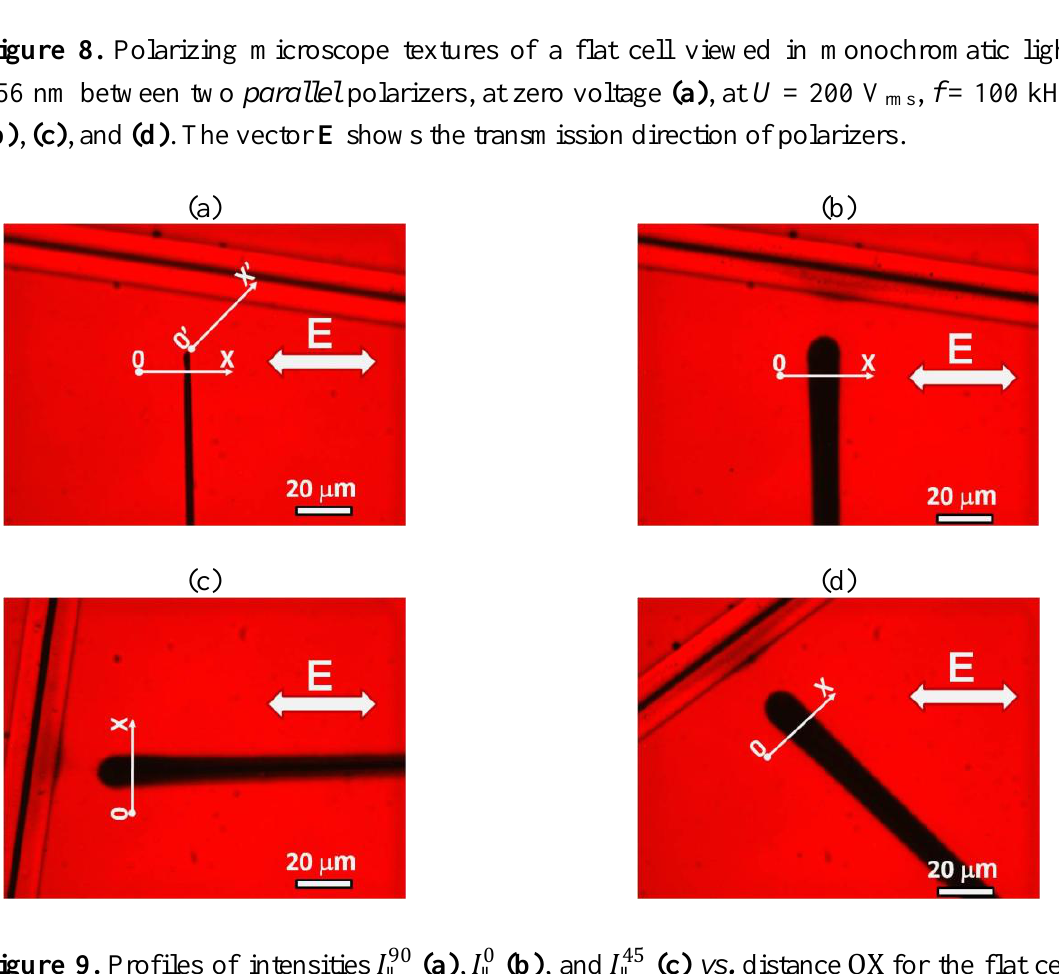
Figure 9. Profiles of intensities 𝐼 ∥90 (a) , 𝐼 ∥0 (b) , and 𝐼 ∥45 (c) vs. distance OX for the flat cell viewed in monochromatic light at 656 nm between parallel